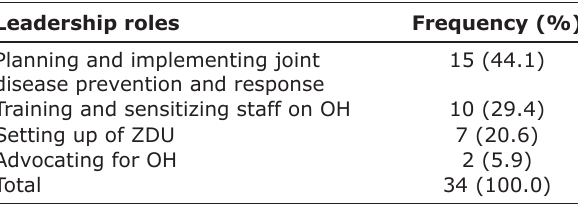
Table-6: Roles of respondents in implementation of the OH